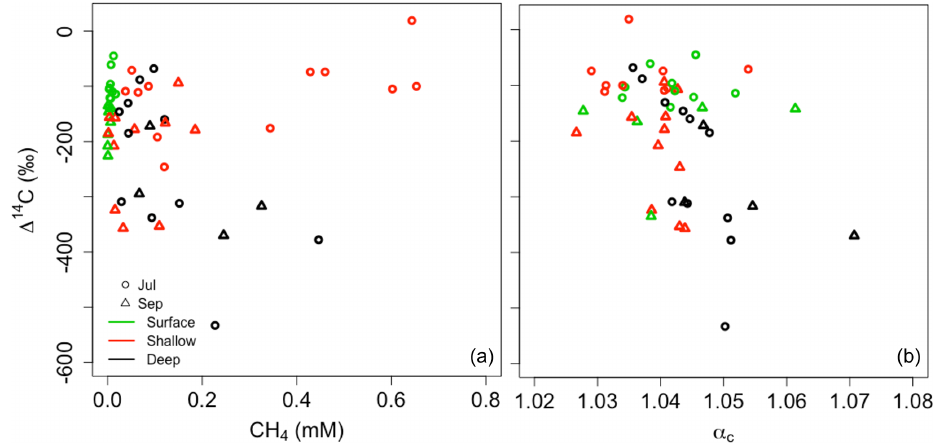
Figure 4. DOC 14 C (reported in this study) versus dissolved methane concentration (a) and the apparent fractionation factor for methano- genesis, α c (b) . Methane concentration, δ 13 C, and α c data were presented previously in Throckmorton et al.